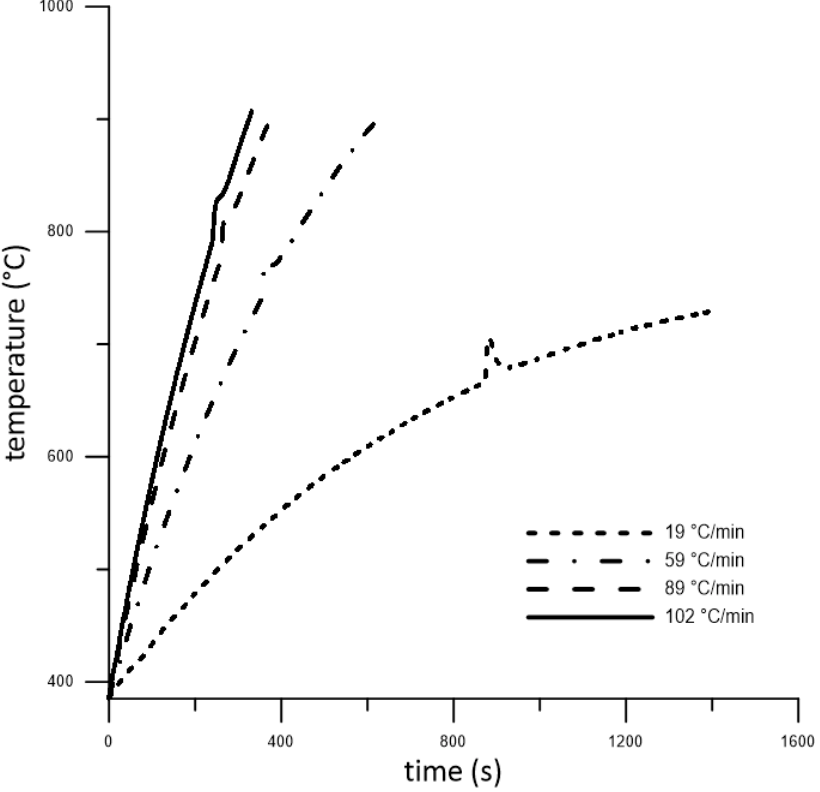
Figure 1. The heating curves obtained at various heating rates.